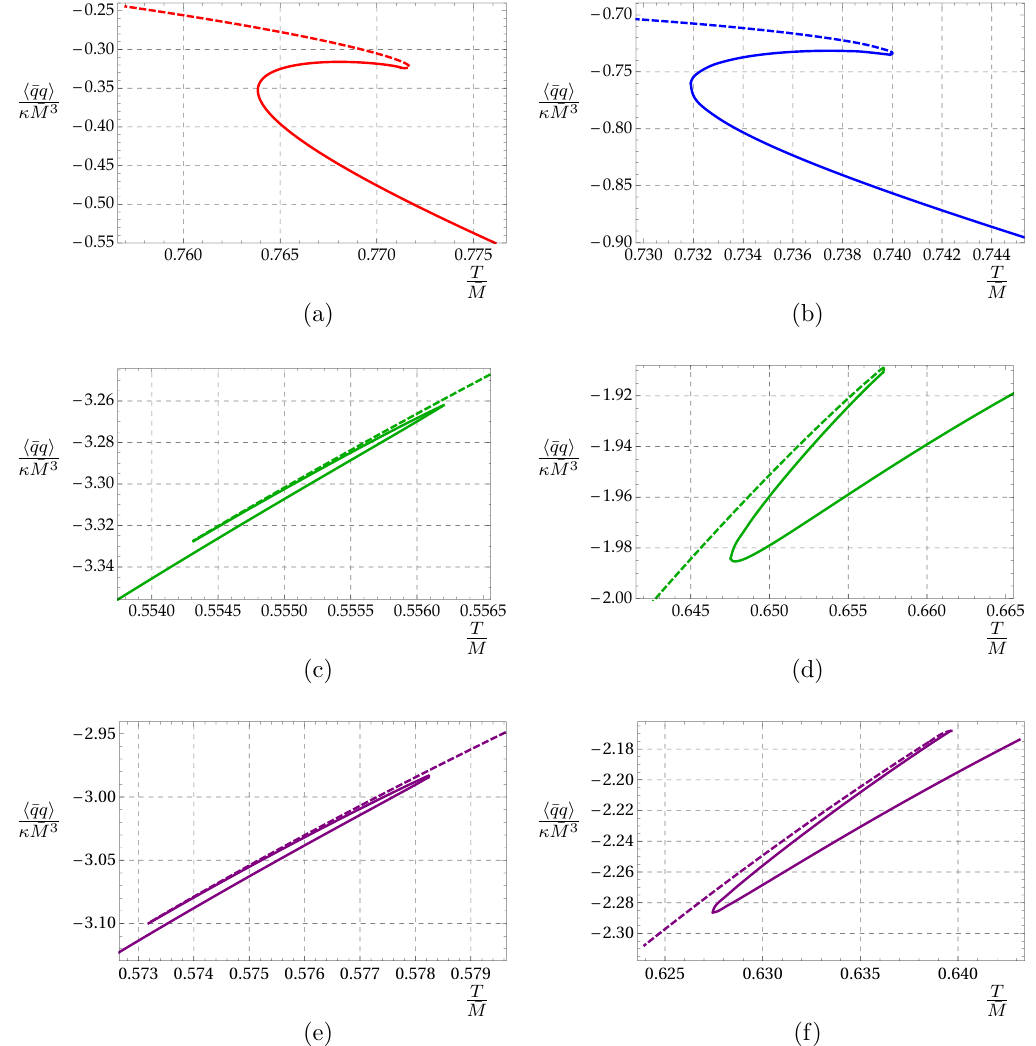
Figure 4 . Zoom into the transition region between Minkowski and black hole embeddings for the quark condensate. The values of the magnetic (cid:12)eld are b= (cid:22) M 2 = 0 (a), 2 (b), 3.3 (c) and (d), and 3.4 (e) and (f). Dashed lines represent Minkowski embeddings, whereas solid lines represent black hole